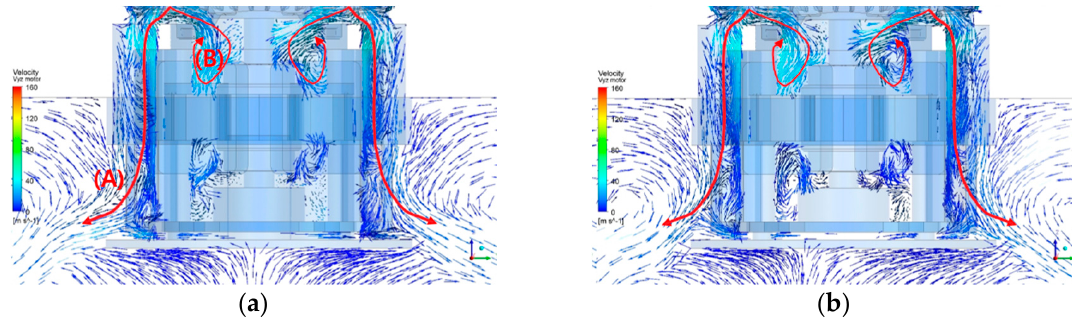
Figure 13. Computational fluid dynamic results of plane of y-z: ( a ) with capacitors; ( b ) without capacitors.